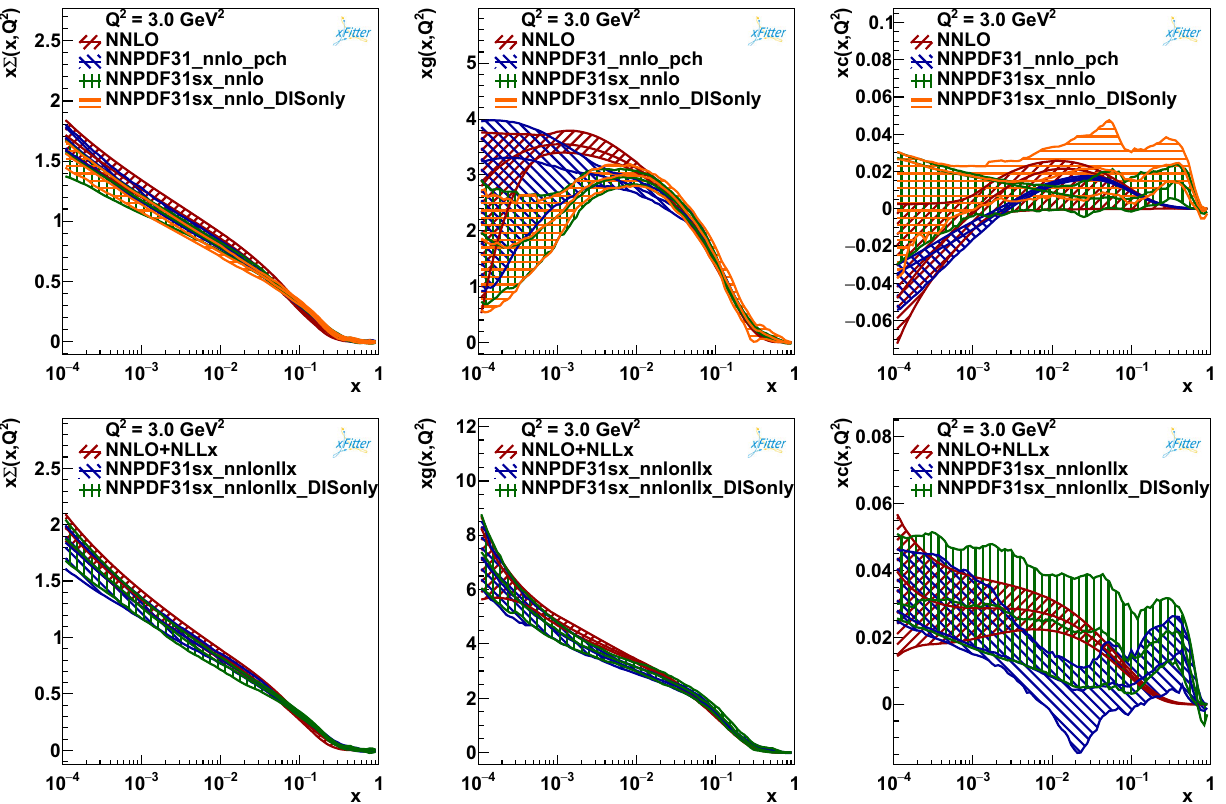
Fig. 9 The total singlet, gluon and charm PDFs for the final fits at NNLO (upper plots) and NNLO+NLL x (lower plots) compared to the analogous NNPDF3.1 determinations FONLL-C prediction which differs when the charm PDFs are fitted. Specifically, when fitting the charm PDFs, it has been pointed out that an extra contribution, denoted by Δ IC , should be added to the FONLL formula to account for poten- tial intrinsic-charm-initiated contributions